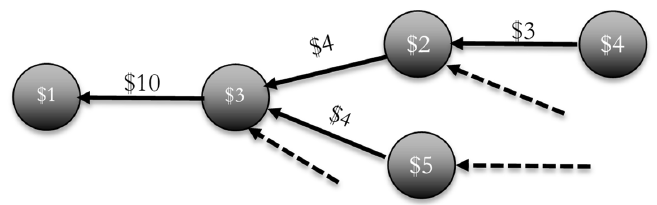
Figure 2. An example of the PED [ T ] pedigree of a $10